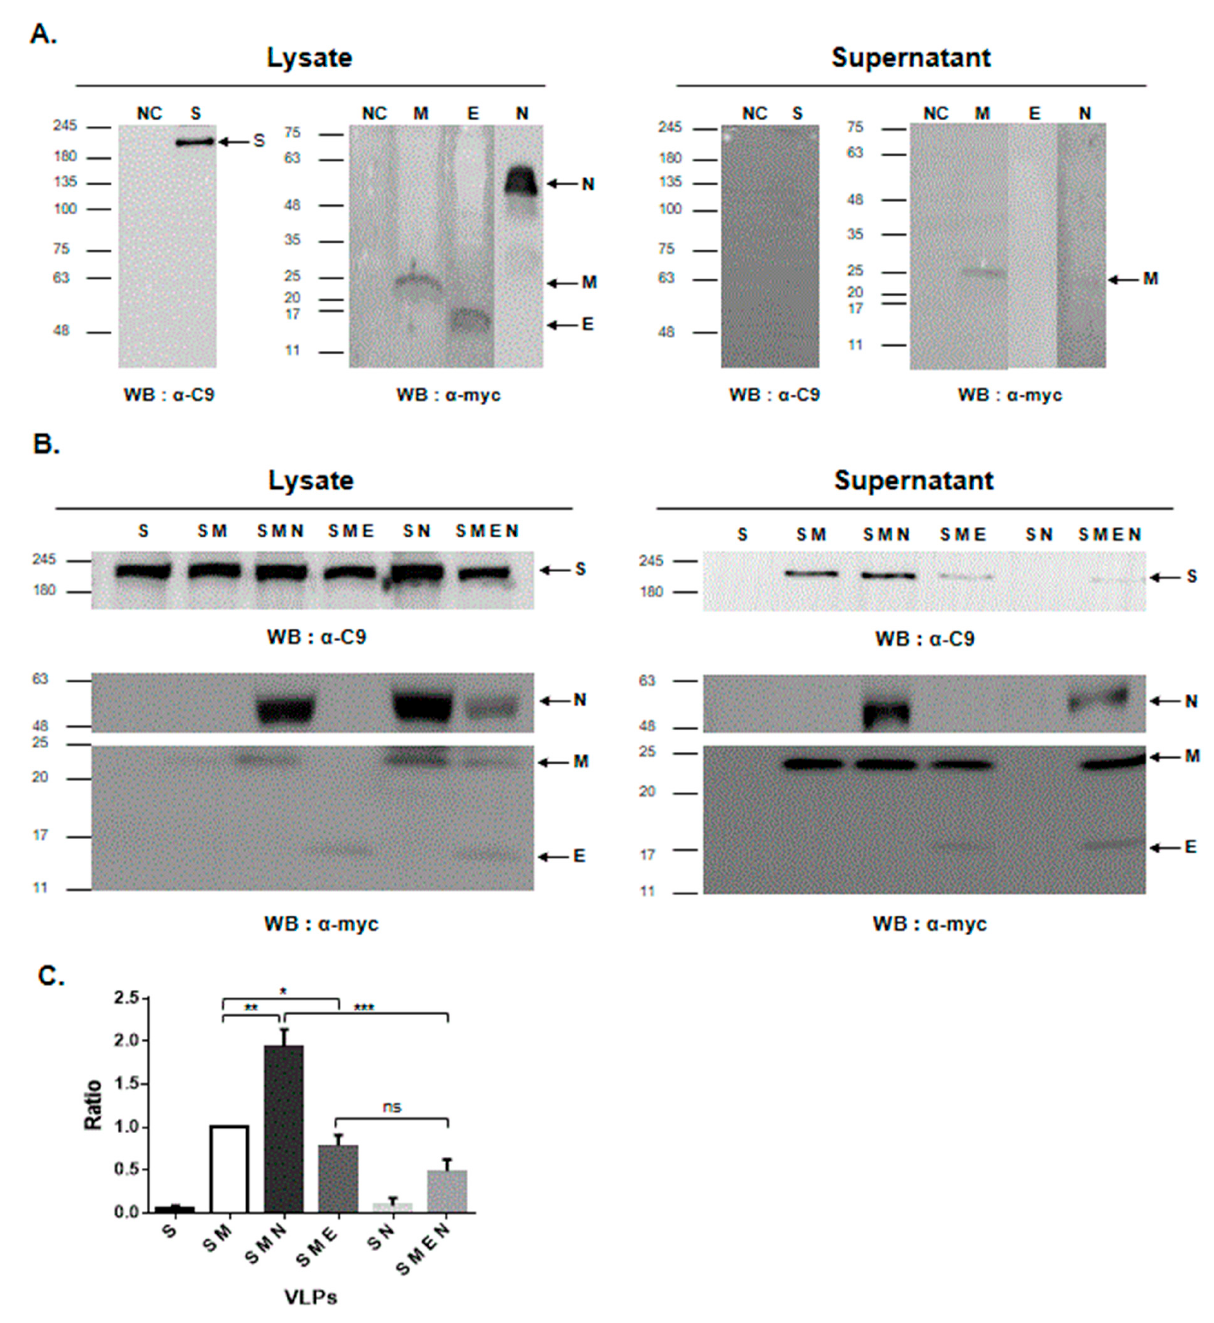
Figure 1. Generation of porcine epidemic diarrhea virus-like particles (PED VLPs) in mammalian expression systems. ( A , B ) HEK293T cells were transfected with the indicated plasmids singly ( A ) or in combinations ( B ). At 48 h post-transfection, the expression of four structural proteins in the cell lysates and supernatants were analyzed using western blotting. The numbers at the left indicate molecular mass in kilodaltons. S, E, M, and N proteins are indicated. ( C ) Band intensities of the S protein in western blot from supernatants in ( B ) were measured and plotted relative to those in cells transfected with S and M proteins. Statistical significance was assessed using Student’s t -test. *, p < 0.05; **, p < 0.01; ***, p < 0.001; ns, not